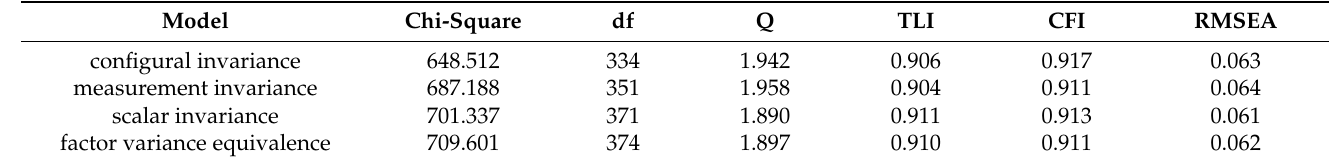
Table 4. Homogeneity verification goodness-of-fit index of parent–coach interaction.